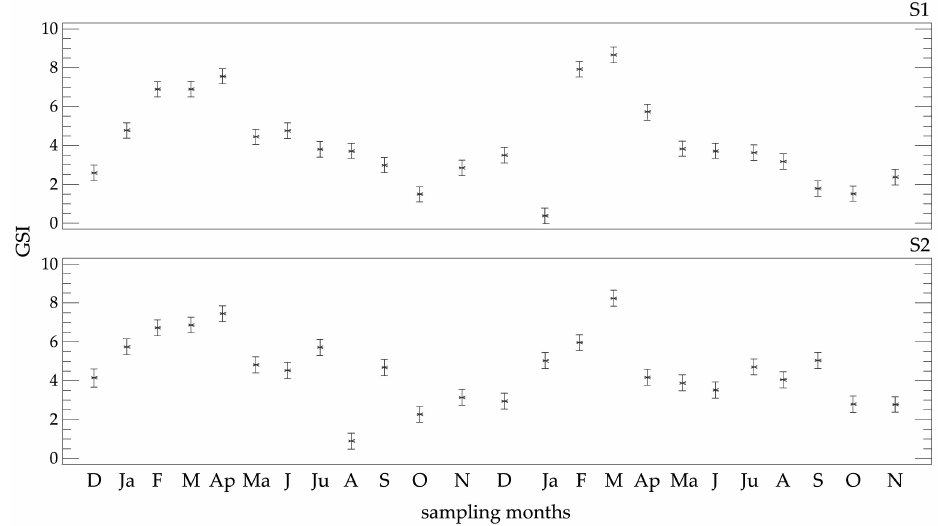
Figure 2. Temporal trend of the mean gonad-somatic index (GSI) ± Fisher LSD of Paracentrotus lividus at the two sampling stations (S1 and S2) in the Pagasitikos Gulf.